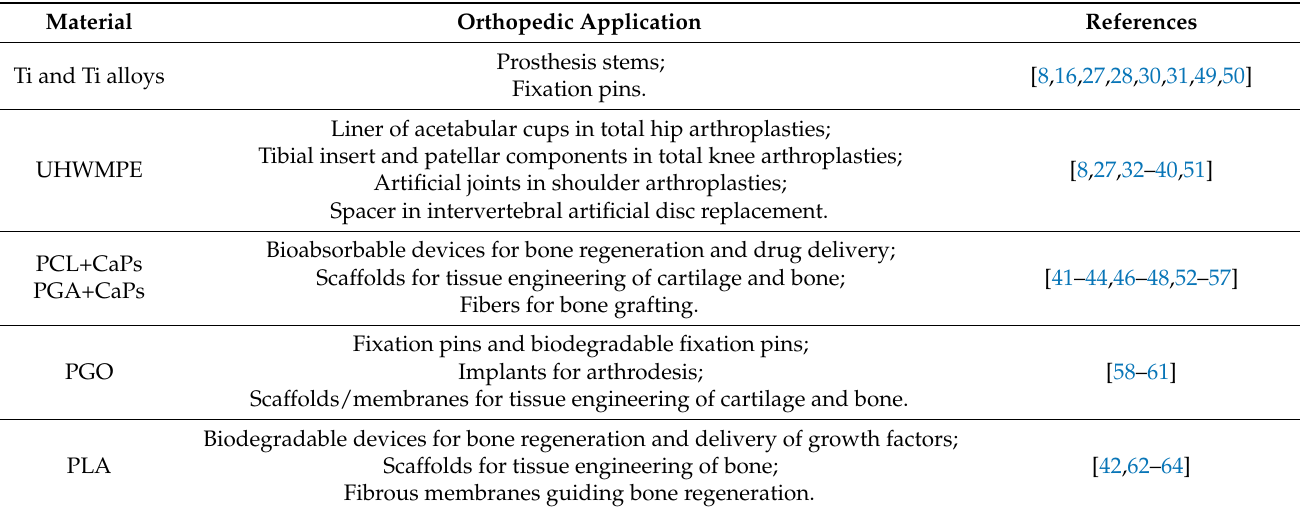
Table 1. Summary of the materials and their orthopedic applications reported in the